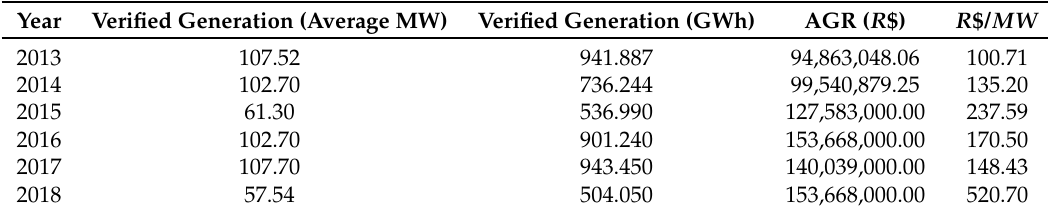
Table 3. Values of Average Generation, Verified Generation, Annual Generation Revenue (AGR) and R $/ MW from 2013 until 2018 of Henry Borden.